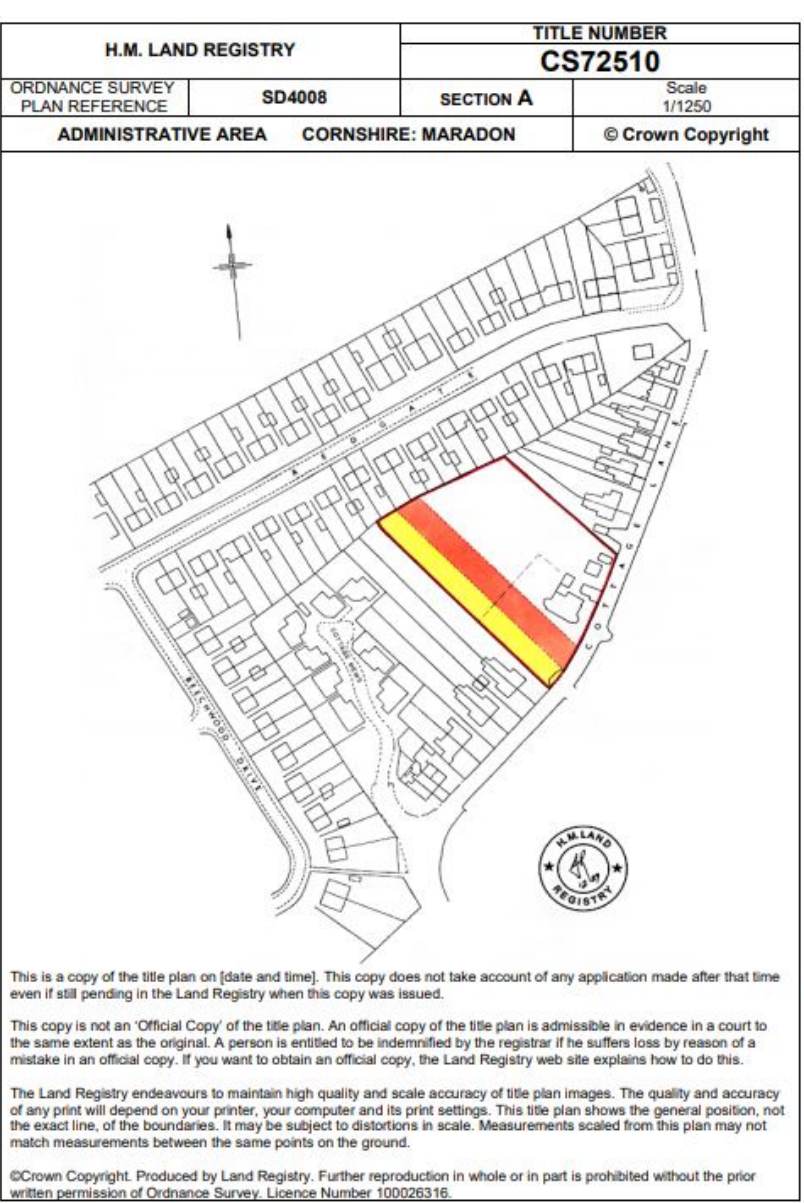
Figure 6. Part of the Title Plan. Source: [31].